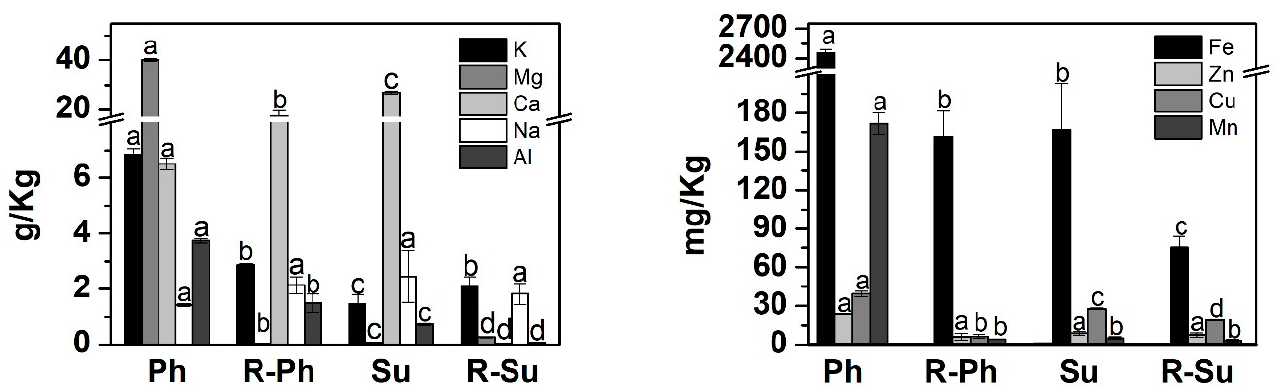
Figure 1. Potassium (K), magnesium (Mg), calcium (Ca), sodium (Na), aluminium (Al), iron (Fe), zinc (Zn), copper (Cu), and manganese (Mn) contents in hydrochar samples (Ph, R-Ph, Su, and R-Su). The letters “a”,”b”, “c”, and “d” were used to indicate statistical difference. Same letters on bars indicate non-significant differences between treatments, and same letters indicate significant differences between treatments. The error bars represent standard deviation (SD).